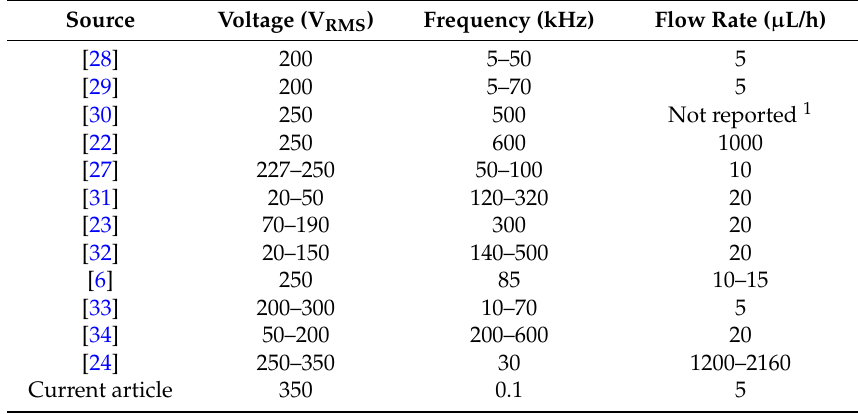
Table 1. List of cDEP publications and their associated operating parameters. As the list consists of alternating current sources, voltage is expressed in root mean square (V RMS